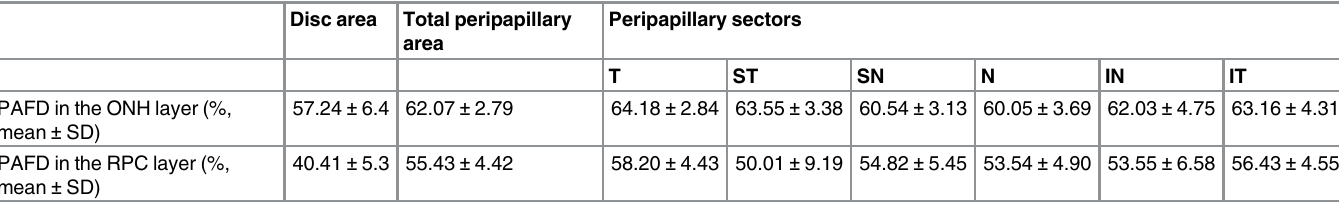
Table 2. Peripapillary angioflow vessel-density (PAFD) in the optic nerve head (ONH) and radial peripapillary capillaries (RPC) layers, respectively. Disc area Total peripapillary